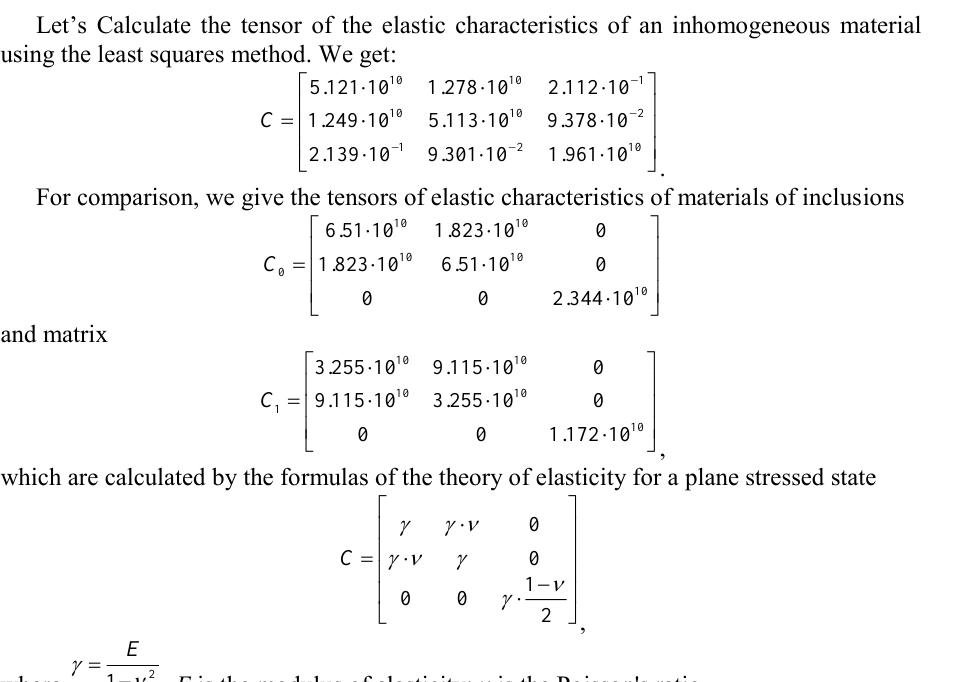
Fig. 13. Micro and macro stresses at the boundary of the region